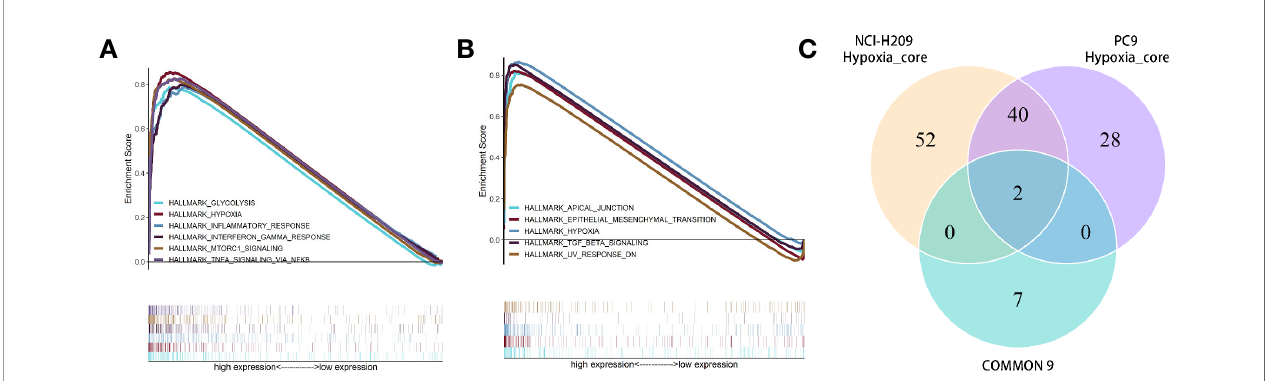
FIGURE 6 | GSEA toward the whole expressed genes in the cells of co-cultured NCI-H209 and brain metastatic PC9. (A) GSEA for the NCI-H209 cells co-cultured with HBMECs. (B) GSEA for the whole expressed genes in the brain metastatic PC9 cells. The gene sets with p - and q -values <0.05 were considered signi fi cantly enriched. (C) Intersection analysis towards three gene sets, including two hypoxia gene sets (respectively enriched in co-cultured NCI-H209 and brain metastatic PC9) and the nine common genes.